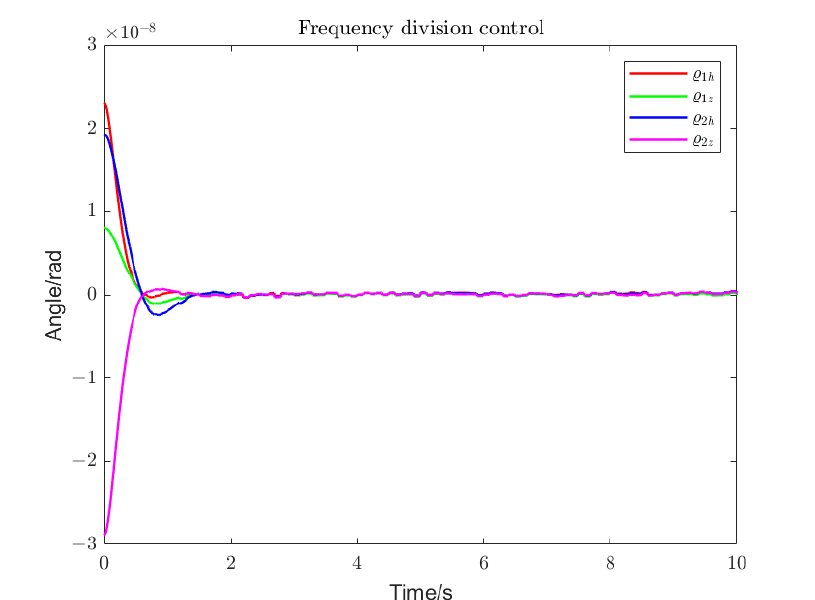
Figure 11. Pointing error of the telescope (frequency division control). With frequency division control, the LOS attitude deviation of the pitch angle and the yaw angle under various disturbances can reach a stable state within 2 s.